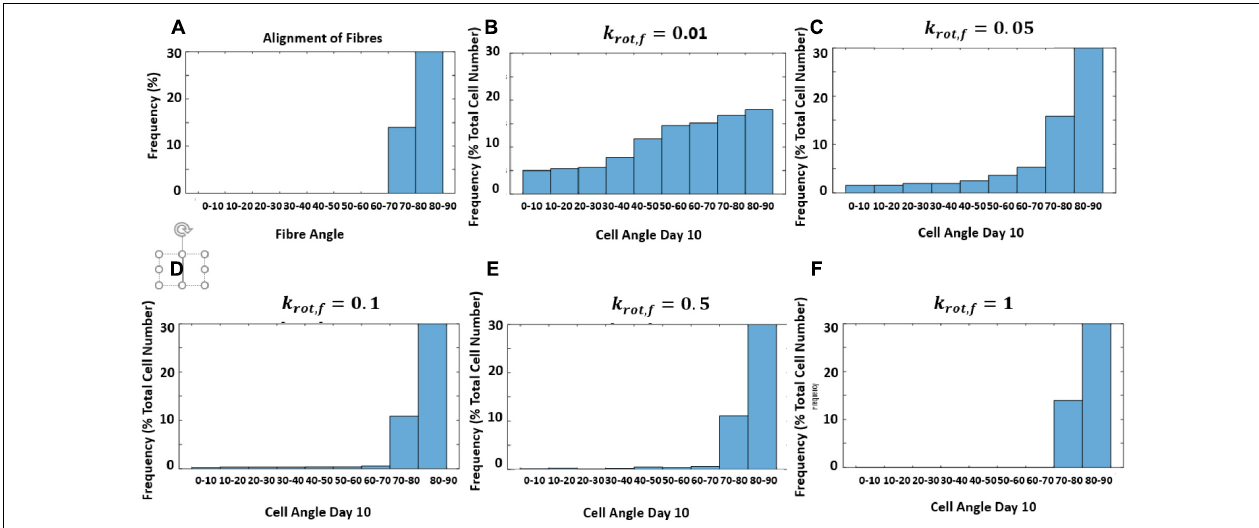
FIGURE 10 | Histogram of predicted cell orientation after 10 days for different values of k rot , f when seeded on the same distribution of fibers; (A) fiber angles in fiber distribution, (B) k rot , f = 0 . 01 (C) k rot , f = 0 . 05 (D) k rot , f = 0 . 1 (E) k rot , f = 0 . 5 (F) k rot , f =